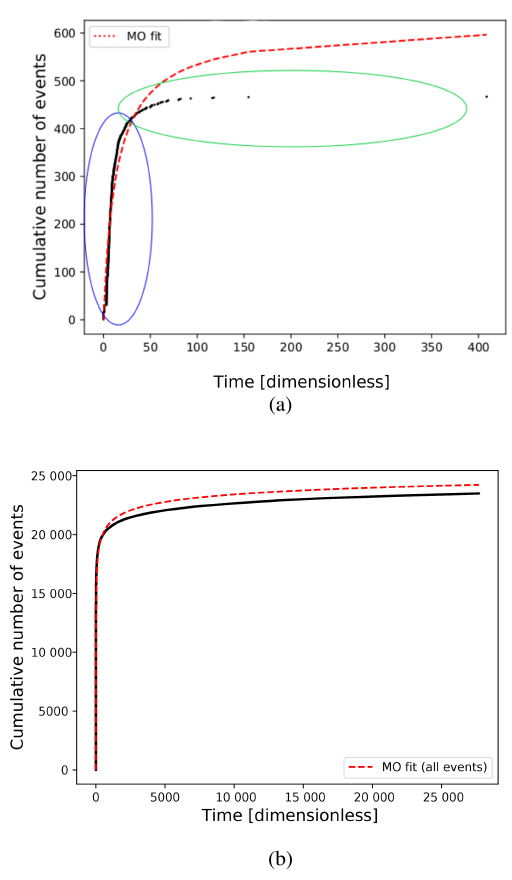
Figure 10. Modified Omori relation (Eq. A11) (dashed red line) fitting for one simulation with P = 0 . 08, π frac = 0 . 90, N = 180. (a) Synthetic aftershocks series for M min = 2 . 0 (black dots). Two regions are distinguished, where the density of events in the blue region is much larger than that in the green. (b) All events gen- erated (minor normal and avalanches) (in black dots). A high and homogeneous data density along the plot is observed.